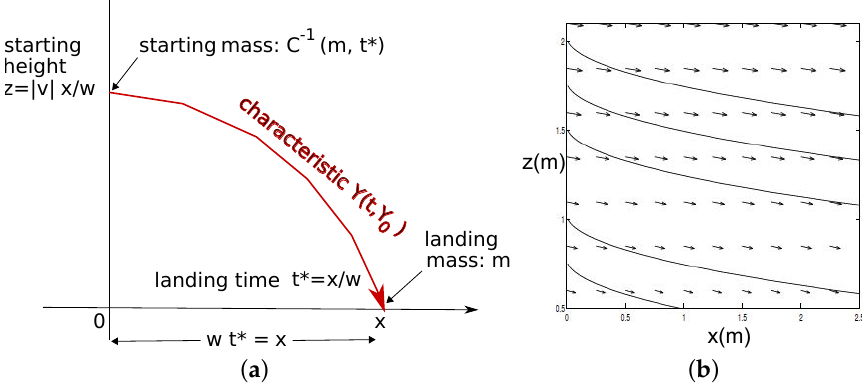
Figure 2. ( a ) Schematic of the method of characteristics. A typical characteristic Y ( t , Y 0 ) is shown as a curved red line; ( b ) Spatial characteristics (solid lines) for the power-law wind profile, with constant vertical velocity, described in Equation (34). The vertical-axis represents height in metres, while the x -axis represents downwind distance in metres. Here w H = 5, β = 0.5, H = 0.5 and v = −